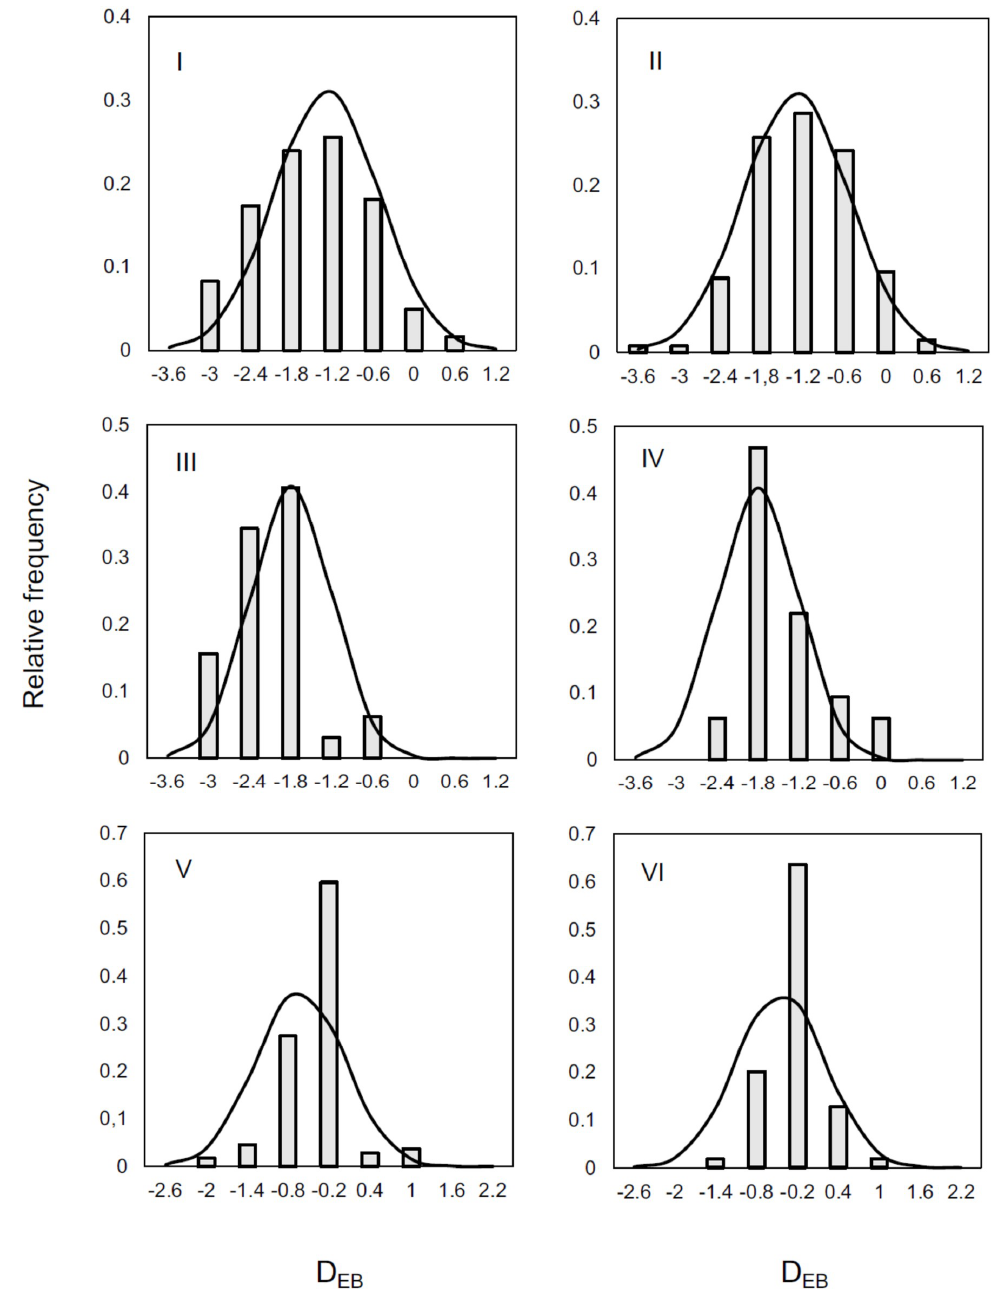
Figure 4. Distribution of D EB values at steps 2 (left) and 3 (right), predicted from D EB data at steps 1 and 4. Minas Gerais: I and II; Paraná: III and IV; and Rio Grande do Sul: V and VI. and 4. Minas Gerais: I and II; Paran á : III and IV; and Rio Grande do Sul: V and